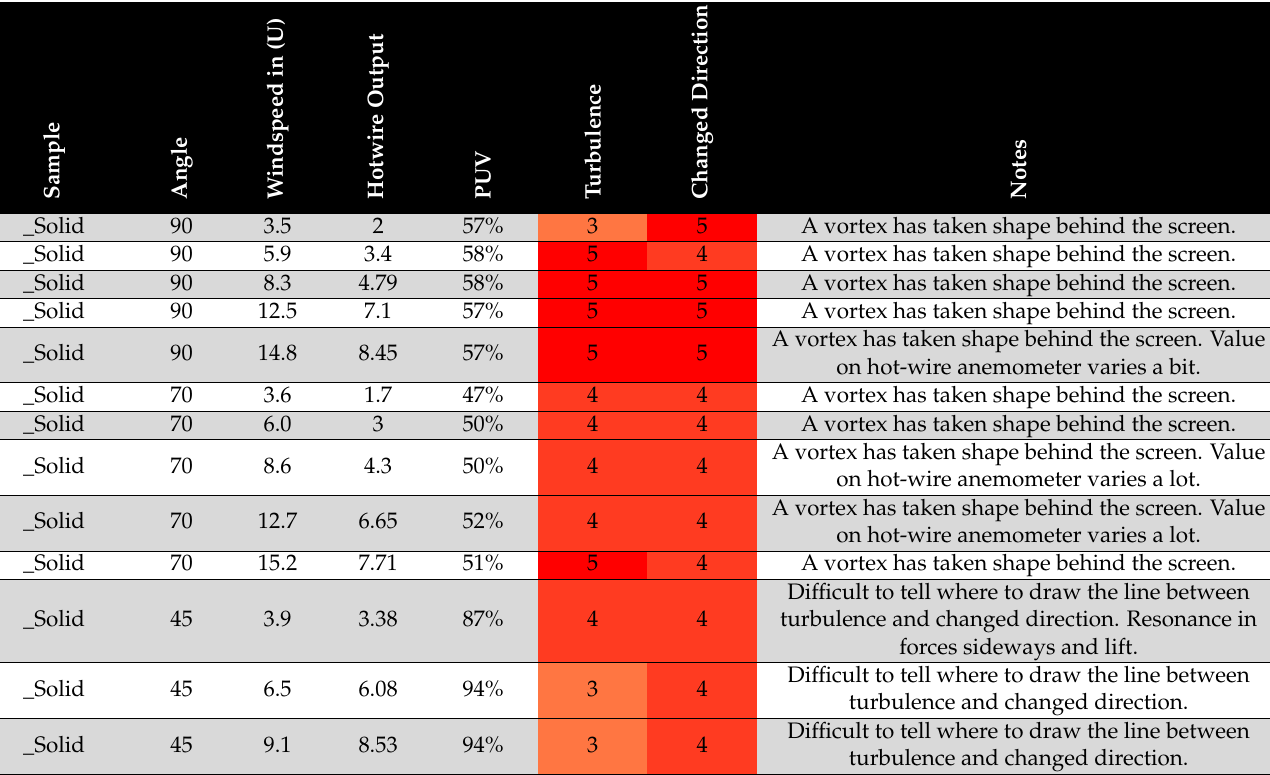
Table A2. Evaluation of turbulence and wind directions downwind from the